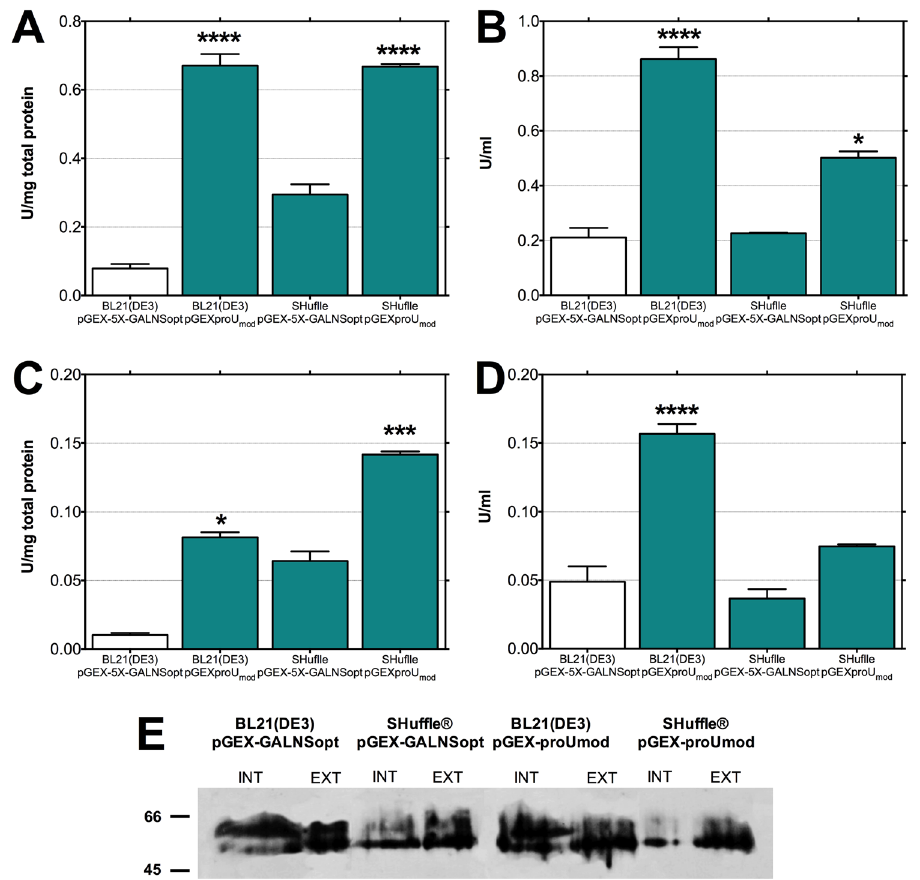
Figure 5. Production of rhGALNS using the promoters tac and proU mod , with two different E. coli strains: BL21(DE3) and SHuffle ® T7. ( A ) Specific activity in the extracellular fraction. ( B ) Volumetric activity in the extracellular fraction. ( C ) Specific activity in the intracellular fraction. ( D ) Volumetric activity in the intracellular fraction. Enzyme activity was assessed 24 hours after induction (no induction was necessary in the case of the promoter proU mod ). A Student’s t-test was performed to assess significance, where ( * ) corresponds to a p-value < 0.05, ( *** ) p-value < 0.001 and ( **** ) p-value < 0.0001. Specific activities are expressed as U rhGALNS/(mg total protein) and volumetric activities as U/ml. ( E ) Western-blot of rhGALNS levels in the intracellular and extracellular fractions in the different studied conditions. All samples were normalized by the amount of total protein. Non-cropped versions of these figures can be found in the Supplementary